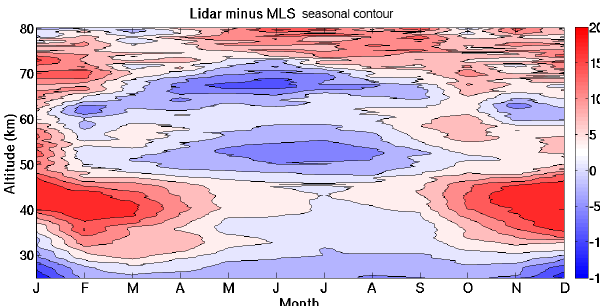
Figure 6. Monthly median temperature difference between lidar and MLS temperature measurements. Red indicates regions where the lidar measures warmer temperatures than MLS and blue regions where the lidar measures colder temperatures than MLS.